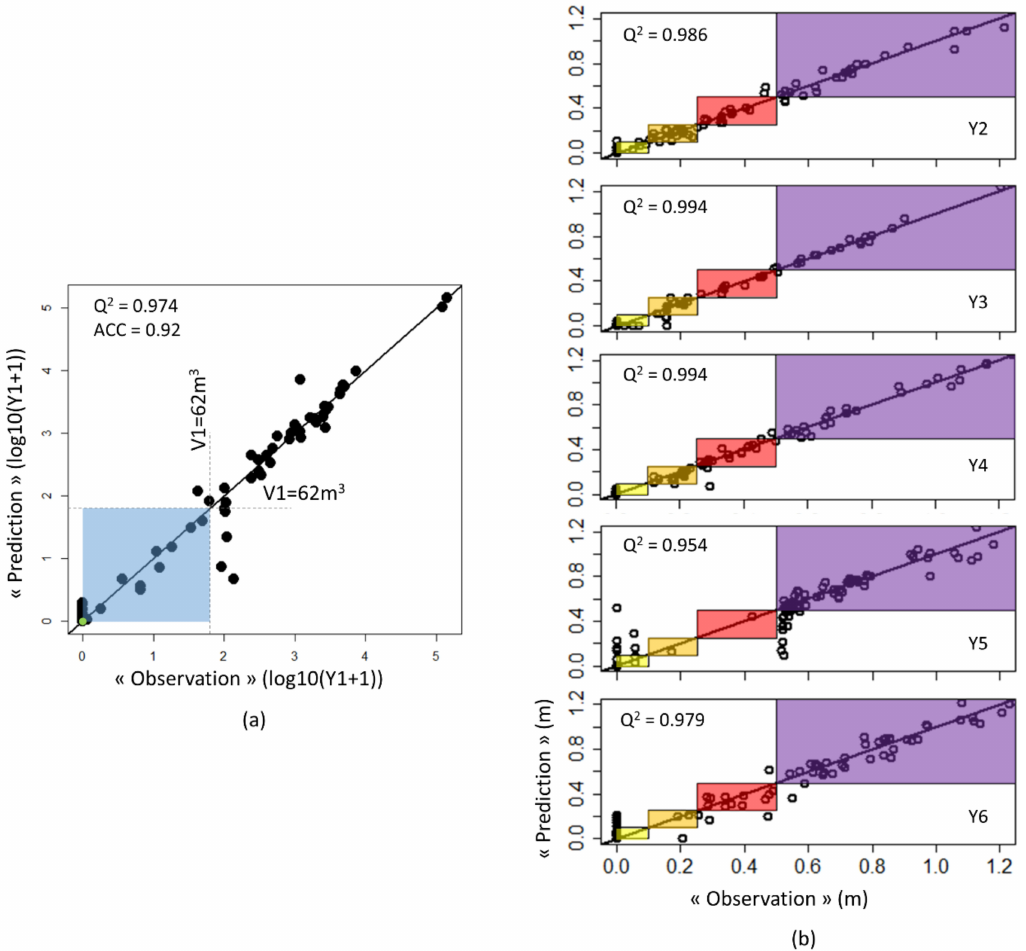
Figure 9. Cross-validation of the Y 1 to Y 6 metamodels: comparison between the observations (the numerically calculated Y num values) and the predictions of the GP-based metamodels. The predictive capability is measured by the coefficient of determination Q 2 (the closer Q 2 is to one, the higher the prediction quality) and the accuracy ( ACC ) for the classifier associated with Y 1 (see Section 2.5.3 for details) The colour scales in panels ( a , b ) correspond to the colour scales of indicators I 1 (classes 1 and 2) and indicators I 2 through I 6 ,